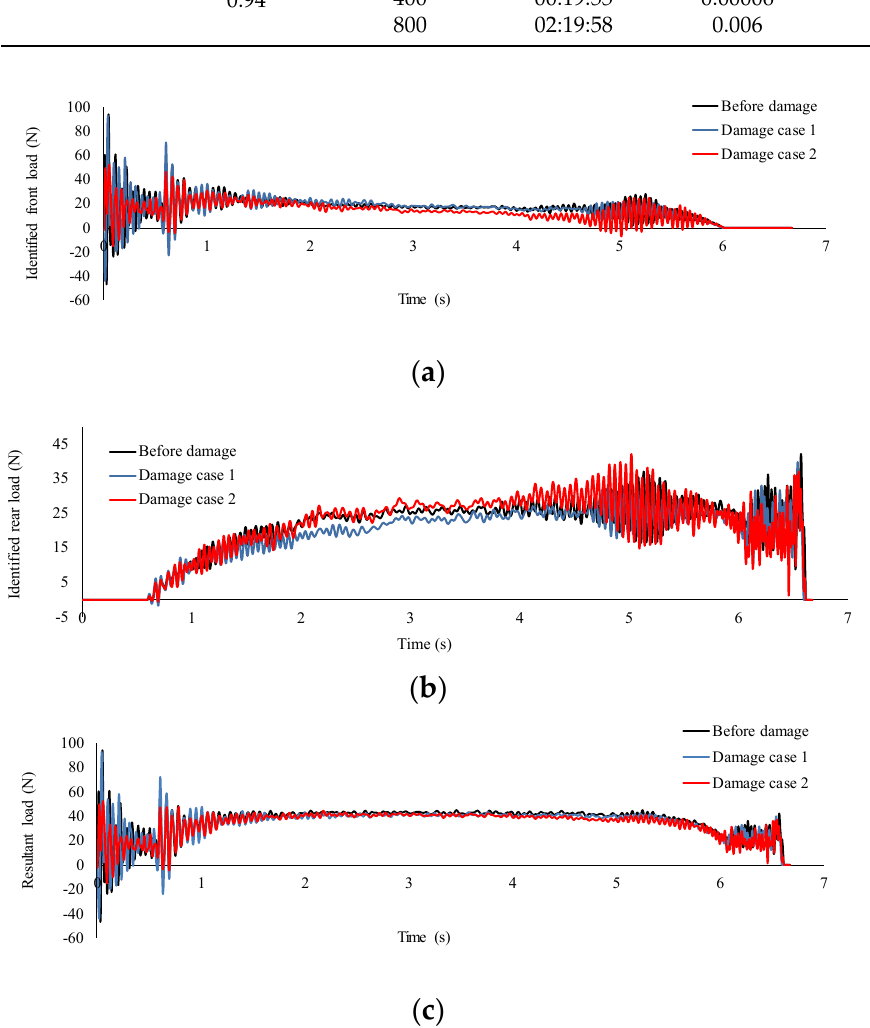
Figure 22. The effect of damage on the identified moving loads at speed of 0.47 m/s (sampling frequency 800 Hz); ( a ) front load; ( b ) rear load; ( c ) resultant load.